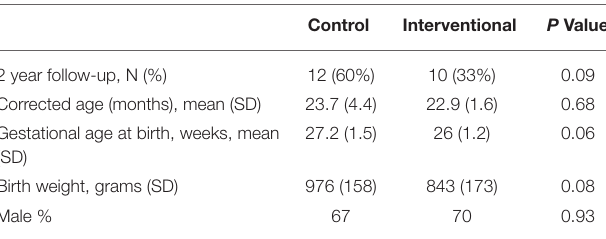
Control Interventional P Value